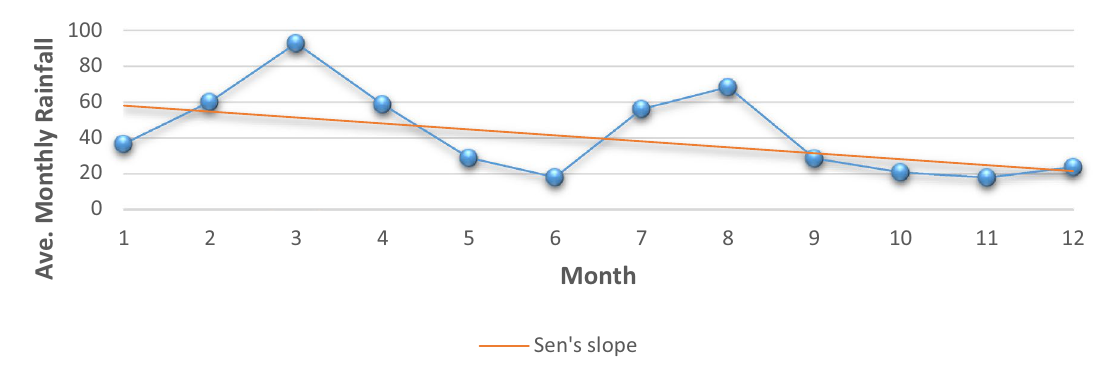
Fig. 3 A plot of average monthly rainfall for Peshawar station. Data Source : Pakistan Meteorological Department and Regional Meteorologi- cal Centre